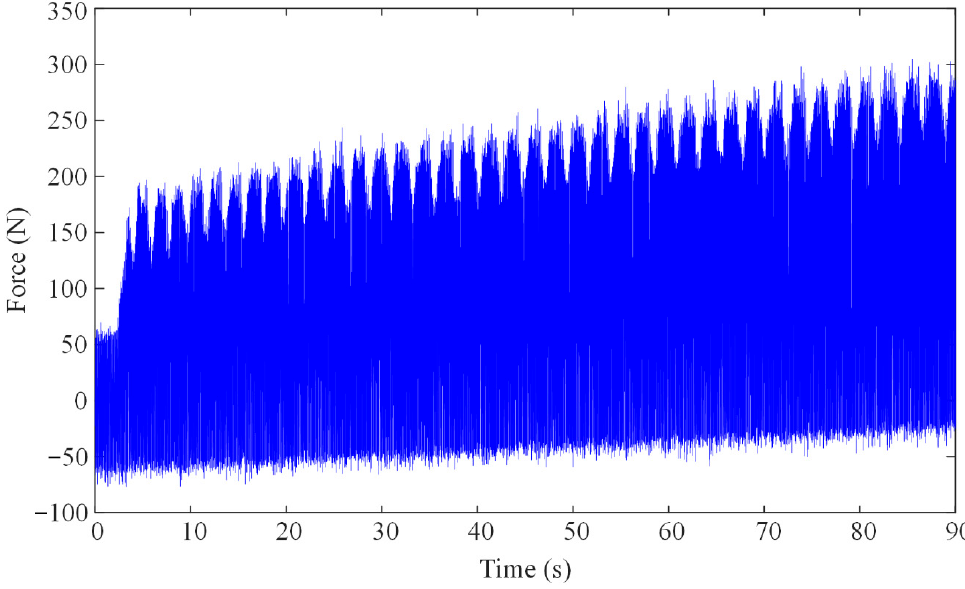
Figure 9. Raw signal of cutting force in a single segment.